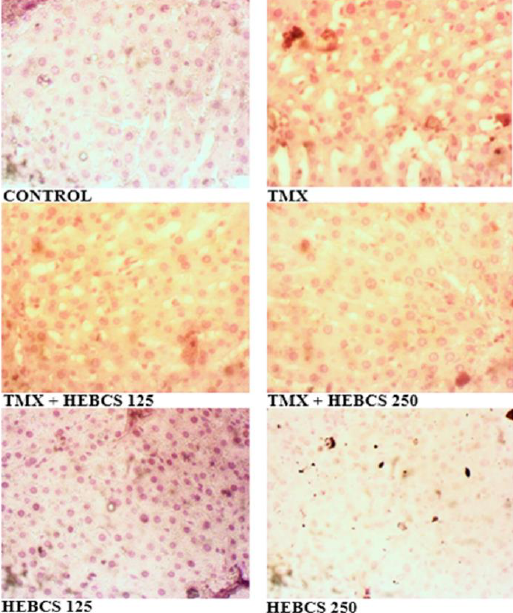
Figure 13. Representative images (×400) of Oil red O stained liver sections. TMX: Tamoxifen; HEBCS 125, 250: Hydroethanolic Extract of Buchholzia coriacea Seeds, 125 and 250 mg/kg body weight.